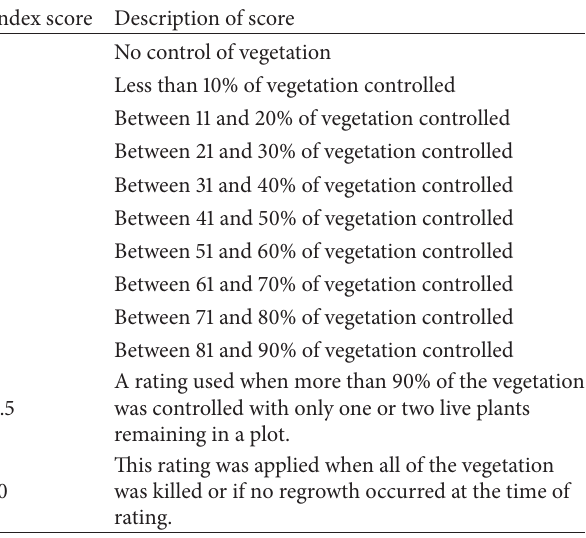
Table 3: Visual indexing for scoring efficacy of